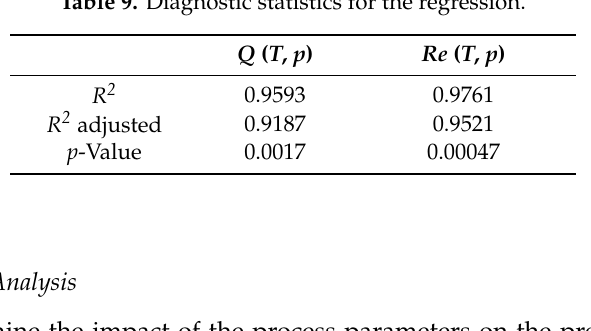
Table 9. Diagnostic statistics for the